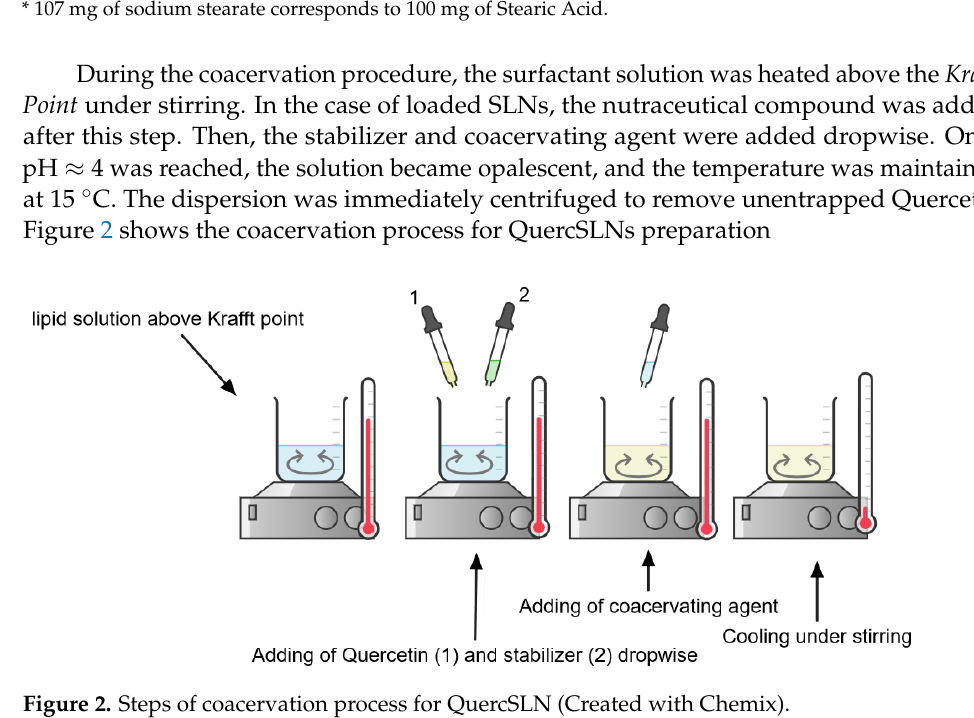
* 107 mg of sodium stearate corresponds to 100 mg of Stearic Acid.